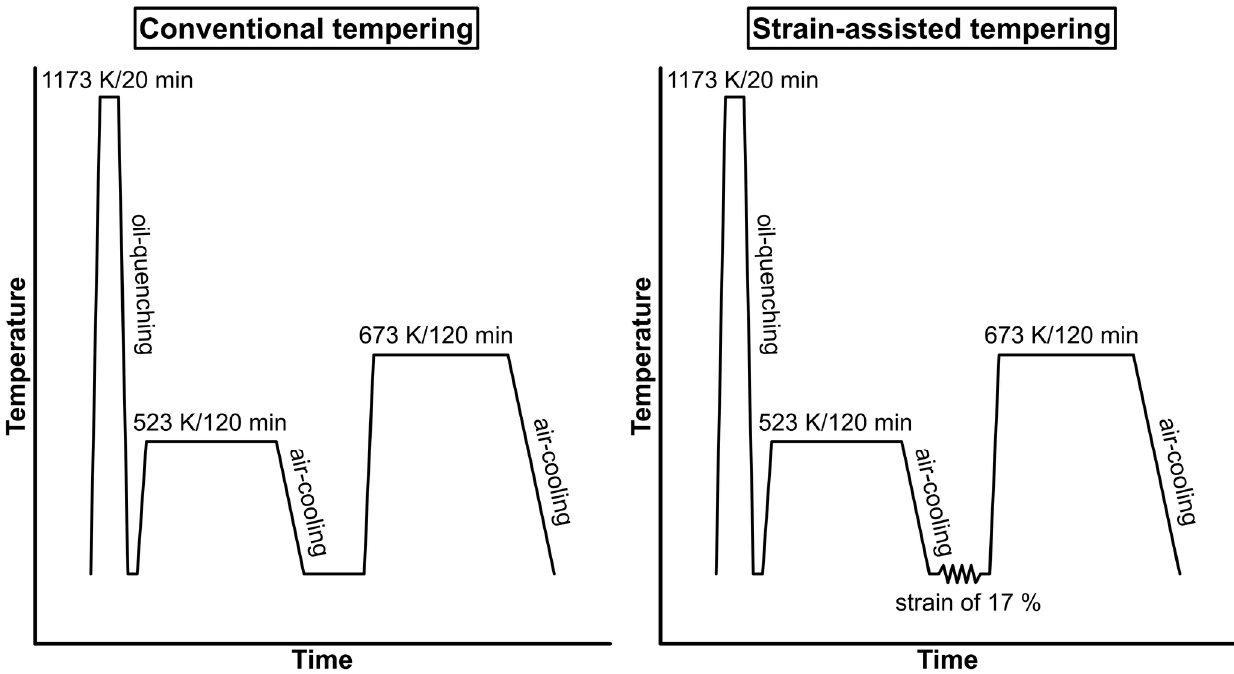
Figure 1. Schematic illustration of the heat